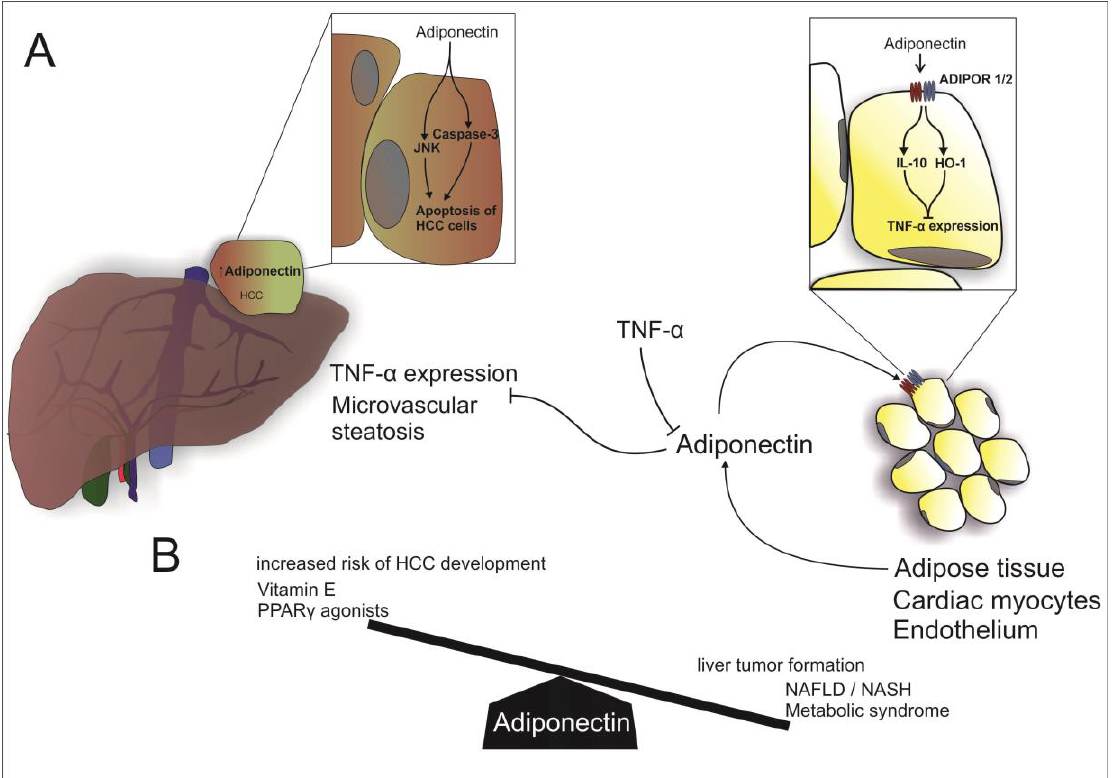
Figure 1. Adiponectin in NAFLD: ( A ) Beside cardiac myocytes and endothelial cells, adiponectin is mostly secreted by adipose tissue. Adiponectin acts in a paracrine manner via binding to ADIPOR 1/2 (Adiponectin receptor 1 and 2) and thereby inducing IL-10 (Interleukin 10) and HO-1 (Heme oxigenase-1), resulting in an inhibition of TNF α (tumor necrosis factor α ) expression. Vice versa, TNF α dampens adiponectin transcription. Furthermore, adiponectin inhibits hepatic TNF α expression and microvascular steatosis. In HCC, adiponectin stimulates apoptosis of cancer cells by activation of Caspase 3 and JAK (Jun N -terminal kinase); ( B ) High levels of adiponectin are associated with an increased risk of HCC and the use of Vitamin E and Peroxisome proliferator-activated receptors γ agonists. On the other hand, low levels of adiponectin are associated with hepatic tumor formation, NAFLD, NASH and the metabolic syndrome.